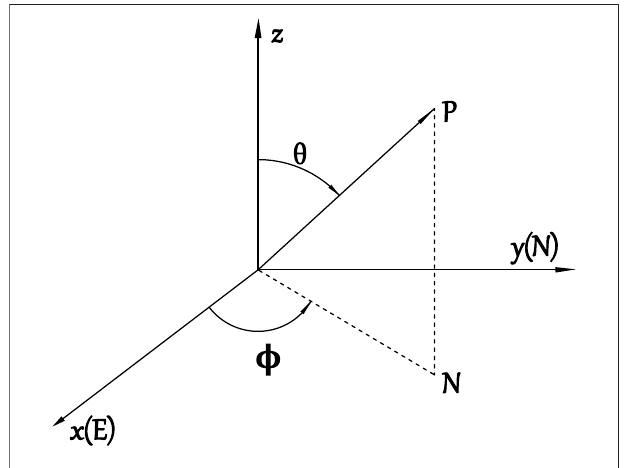
FIGURE 1 | Fracture vector